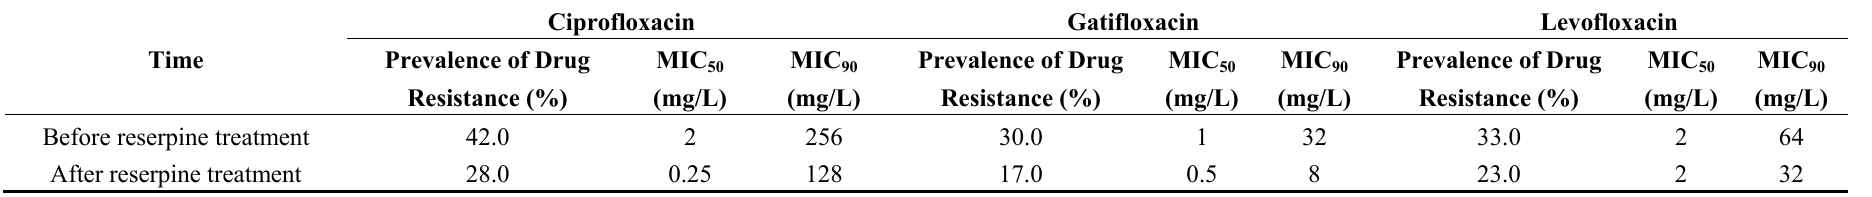
Table 8. Changes of antimicrobial sensitivity in 100 enterococcal isolates following treatment with 20 mg/L reserpine. Antibiotics